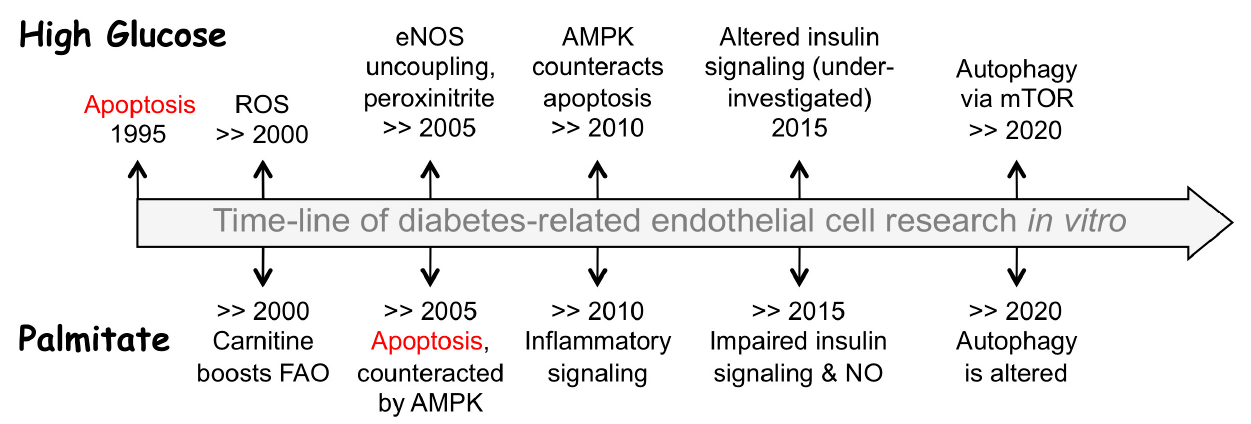
Figure 1. Schematic view of research progress using endothelial cell-based models of hyperglycemia (high glucose, top) or hyperlipidemia (palmitate, underneath). The legends next to the years depict major advances in identifying the key detrimental events and molecular players further detailed in the text. Abbreviations: AMPK, AMP-activated protein kinase; eNOS, endothelial NO-synthase; FAO, fatty acid oxidation; mTOR, mammalian target of rapamycin; NO, nitric oxide; ROS, reactive oxygen